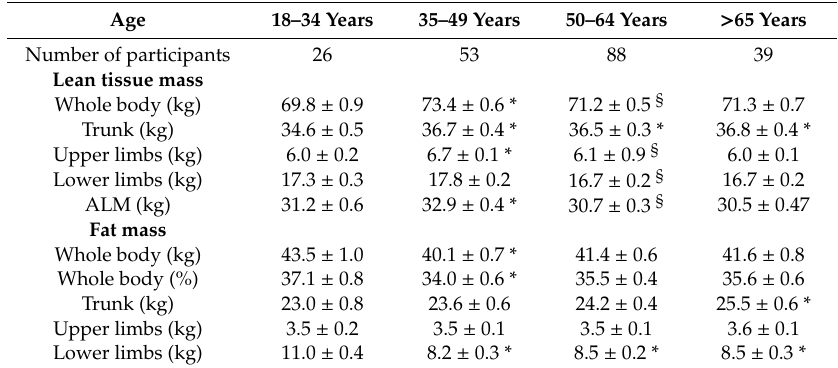
Table 2. Segmental body composition adjusted for weight and height according to the age bracket in men.